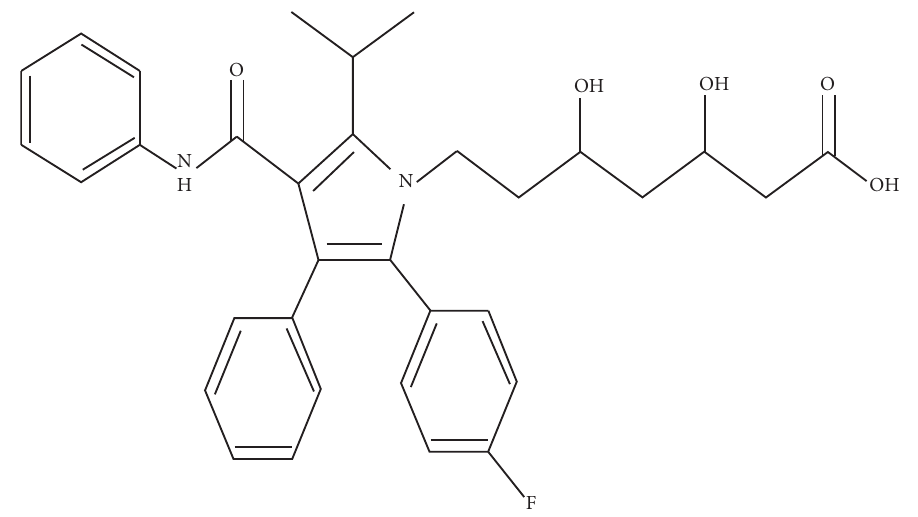
Figure 1: Chemical structure of